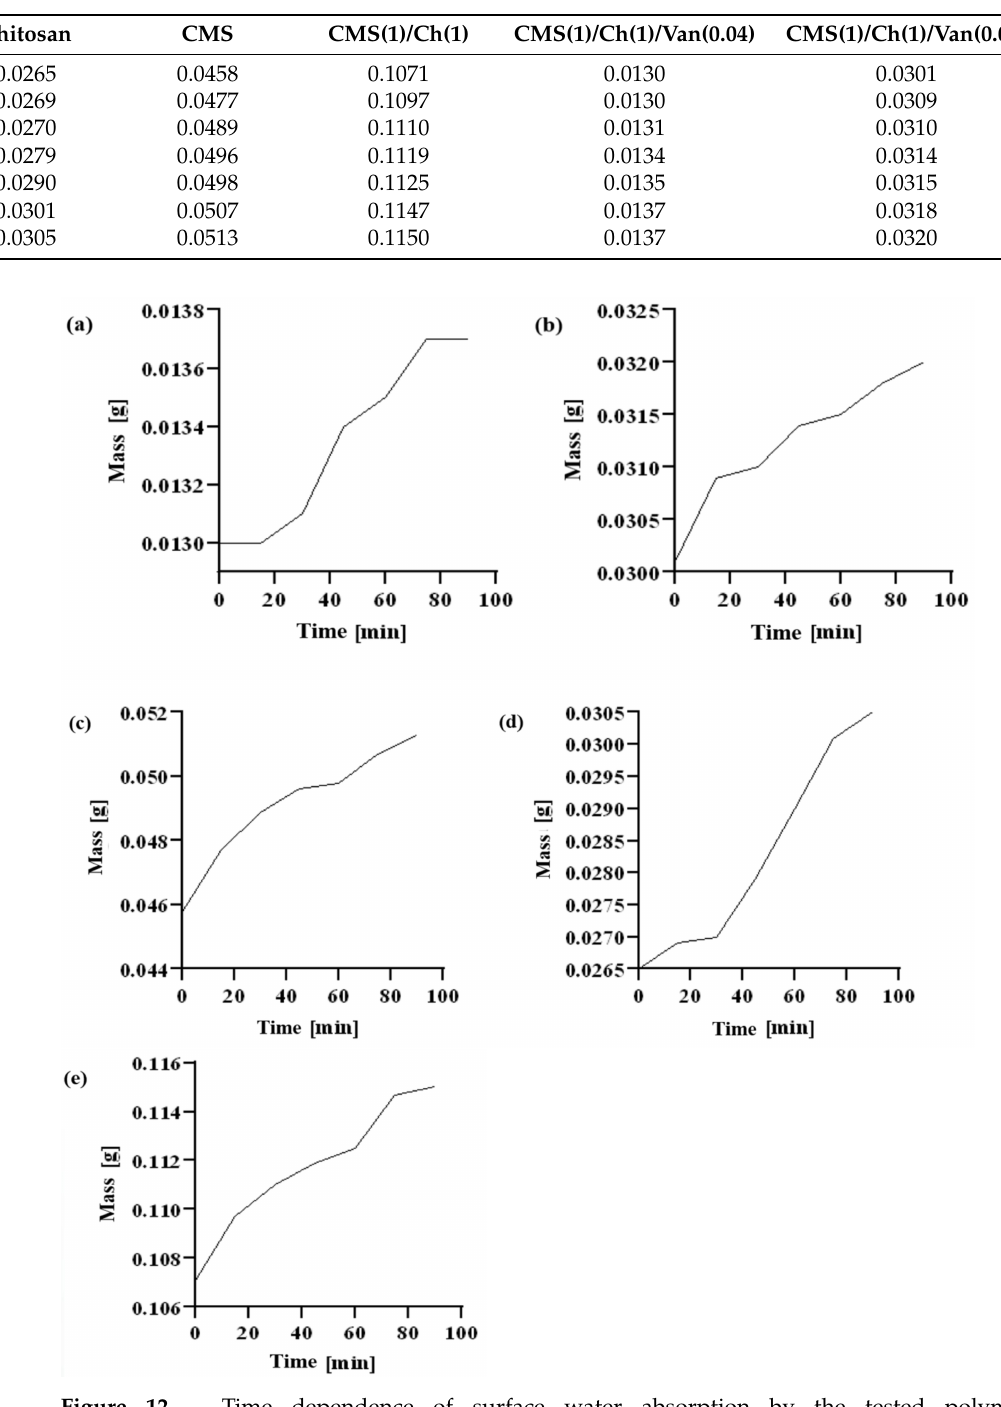
Figure 12. Time dependence of surface water absorption by the tested